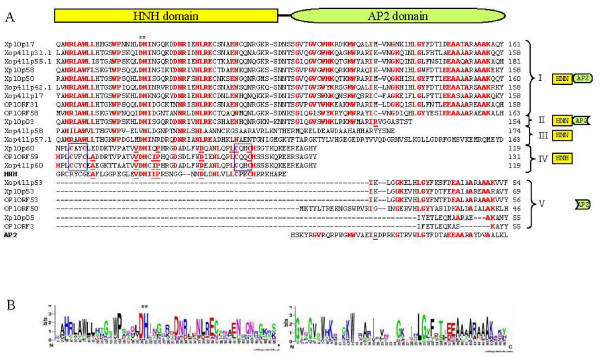
Alignment of the 21 putative HNH endonucleases from the three Xoo phages. (A) Sequence alignment. The conserved residues are in bold-face and the boxes indicated the cysteine dyads (CX2C) flanking the conserved Asp/His residue (*). (B) Consensus sequences of HNH and AP2 domains, displayed using Weblogo.